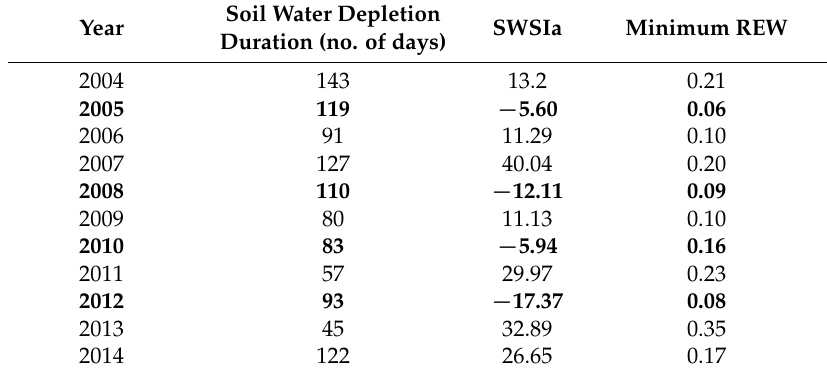
Table 1. Annual soil water depletion duration, annual sum of soil water stress index (SWSIa) during the water depleted period, and annual minimum REW from 2004–2014. Soil Water Depletion SWSIa Minimum REW Year Duration (no. of days) 2004 143 13.2 0.21 2005 119 − 5.60 0.06 2006 91 11.29 0.10 2007 127 40.04 0.20 2008 110 − 12.11 0.09 2009 80 11.13 0.10 2010 83 − 5.94 0.16 2011 57 29.97 0.23 2012 93 − 17.37 0.08 2013 45 32.89 0.35 2014 122 26.65 0.17